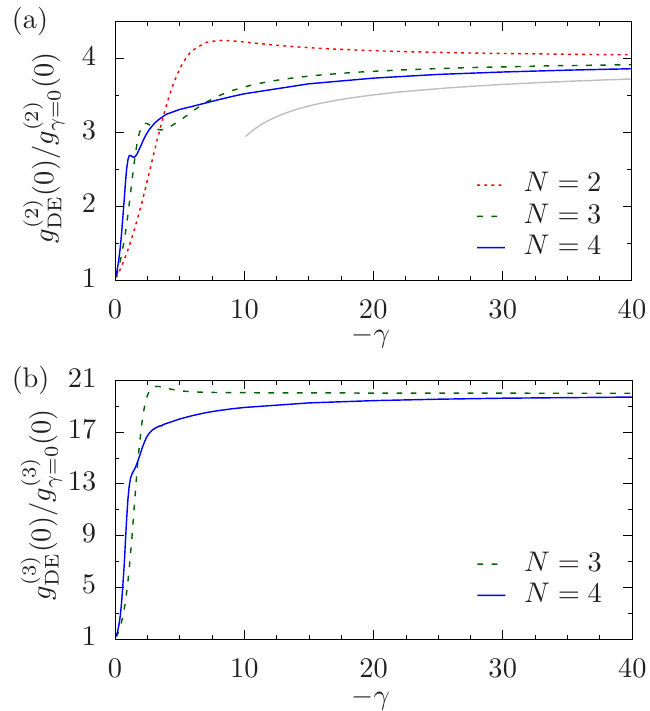
Figure 10: Diagonal-ensemble values of local correlation functions following quenches of the ( 2 ) ( 0 ) / g ( 2 ) ( 0 ) of the local second- interaction strength from zero to γ . (a) Enhancement g γ = 0 DE order correlation over the initial ideal-gas value, for quenches to γ for particle numbers N = 2,3, and 4. The light grey solid line indicates the quench-action strong-coupling (order- 1 /γ 3 ) thermodynamic-limit prediction for the stationary value of g ( 2 ) ( 0 ) [ 35, 36 ] . (b) En- ( 3 ) ( 0 ) / g ( 3 ) ( 0 ) of the local third-order correlation over the ideal-gas value, for hancement g γ = 0 DE quenches to γ and particle numbers N = 3 and